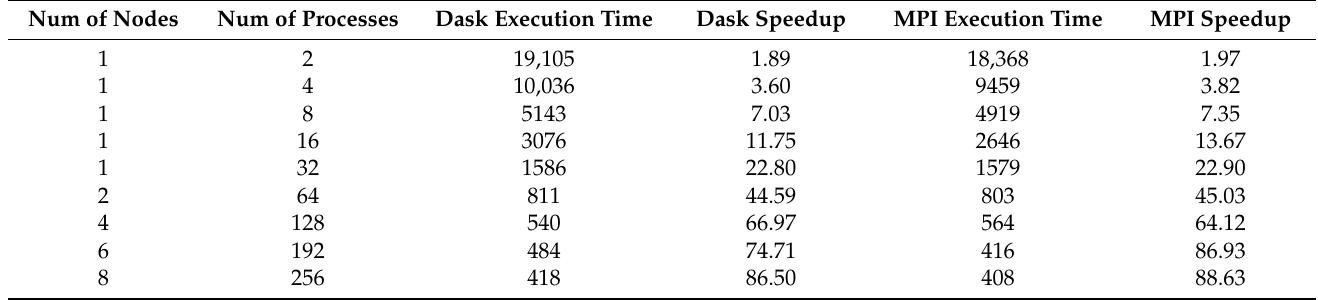
Table 6. Execution time (in seconds) and speedup results for scalability evaluation. The serial execution of the one-month data aggregation takes 36,162 s, which serves as a baseline to calculate the speedup of our parallel approaches with Dask and MPI.